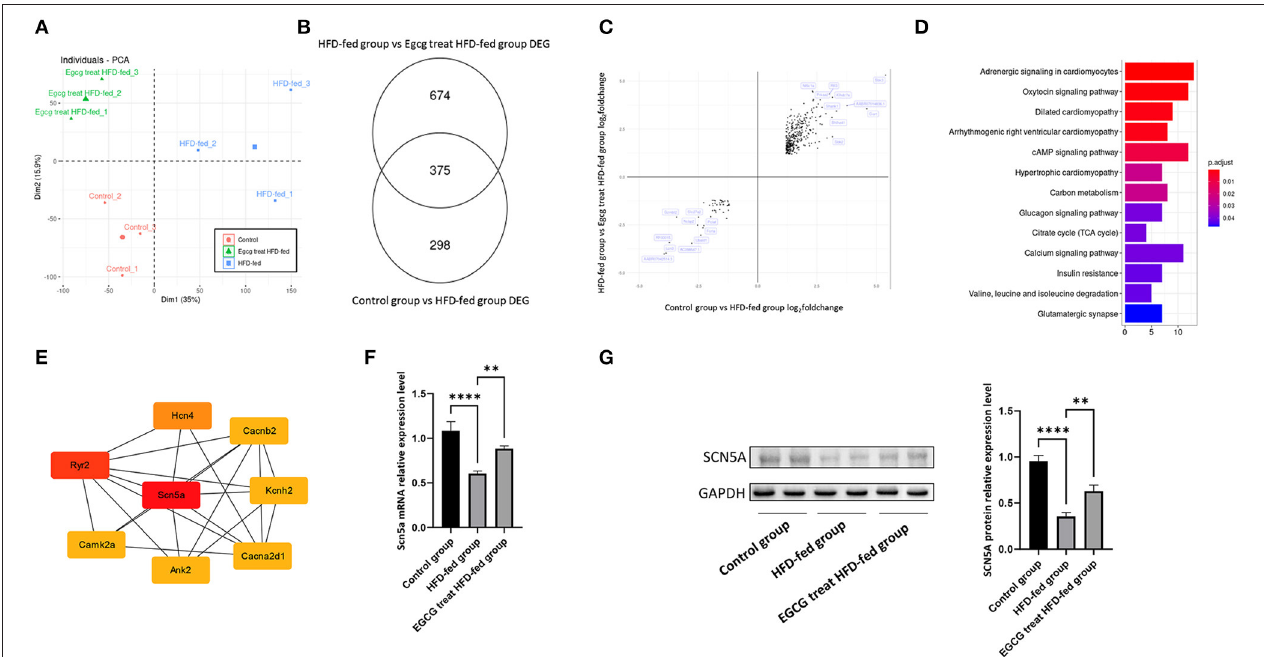
FIGURE 3 | RNA-seq reflect Scn5a is a hub gene of EGCG in alleviating obesity-induced myocardial fibrosis. (A) Principal Component Analysis was performed on RNA-seq; (B) The number of differently expression gene was identified by Deseq2; (C) The cross-volcano map reflects the reverse of gene expression by EGCG treatment; (D) The KEGG pathway enrichment pf reversed gene sets revealed that the change of glucose and lipid metabolism; (E) PPI network analysis showed that Scn5a was a hub gene in EGCG alleviating obesity-induced myocardial fibrosis; (F) The relative mRNA expression levels of Scn5a in the different groups; (G) The effect of EGCG on the expression of SCN5A proteins was detected by western blot with GAPDH as a loading control in the heart. (* p < 0.05, ** p < 0.01, *** p <